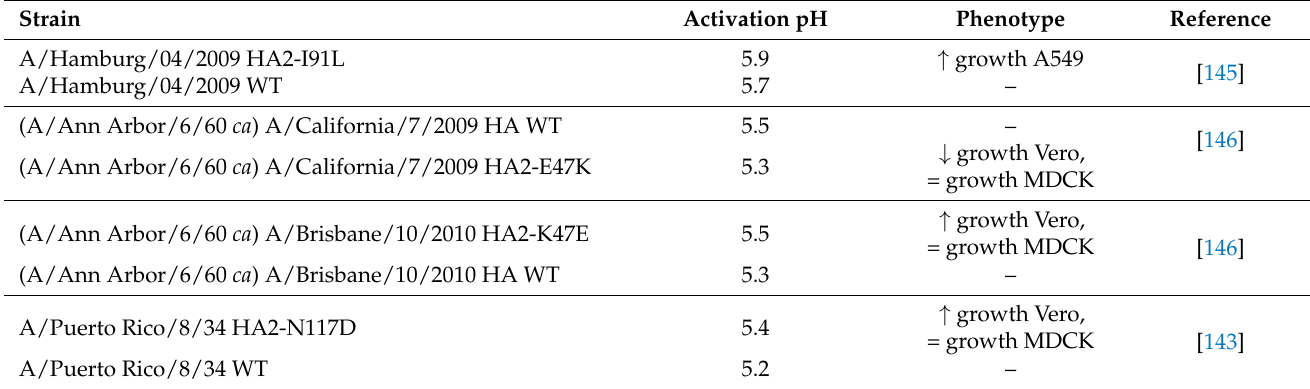
Table 1. Phenotypes of seasonal and pandemic H1N1 variants in